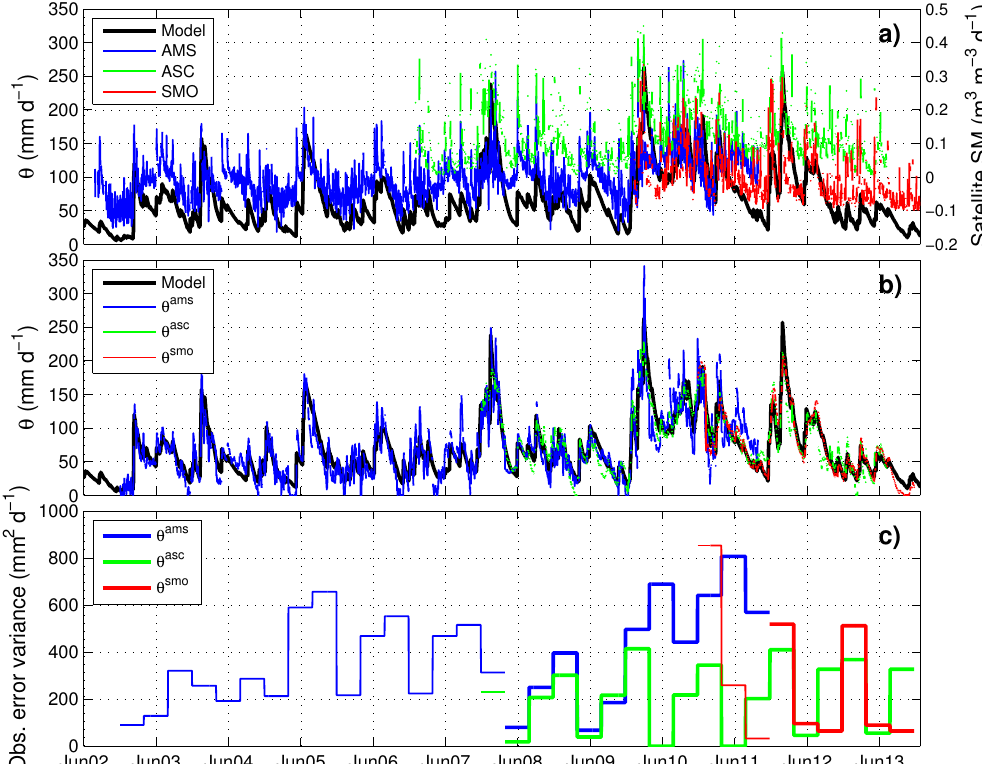
Figure 8. (a) shows the model soil moisture on the left axis ( θ ) and the satellite soil moisture observations on the right axis. (b) shows the soil moisture on the model space, after the three satellite data sets were transformed into a soil wetness index (SWI) and then rescaled by using TC or LV ( θ ams , θ asc and θ smo ). (c) shows the rescaled satellite SM observations error